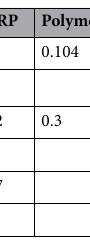
Table 2. The mechanical properties of layers